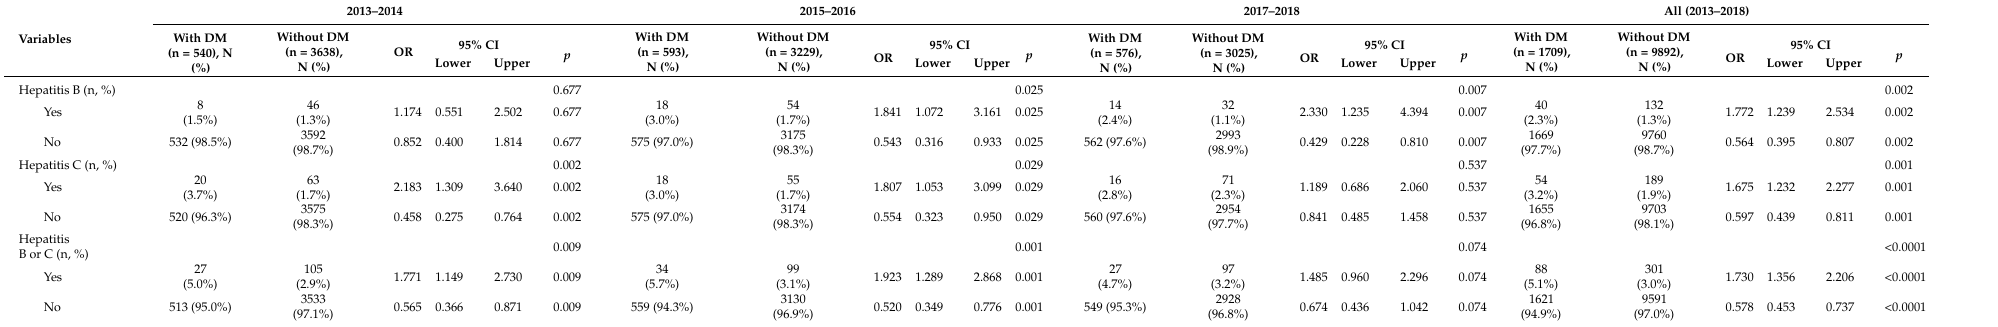
Table 2. Characteristics of hepatitis infection status in with and without diabetes